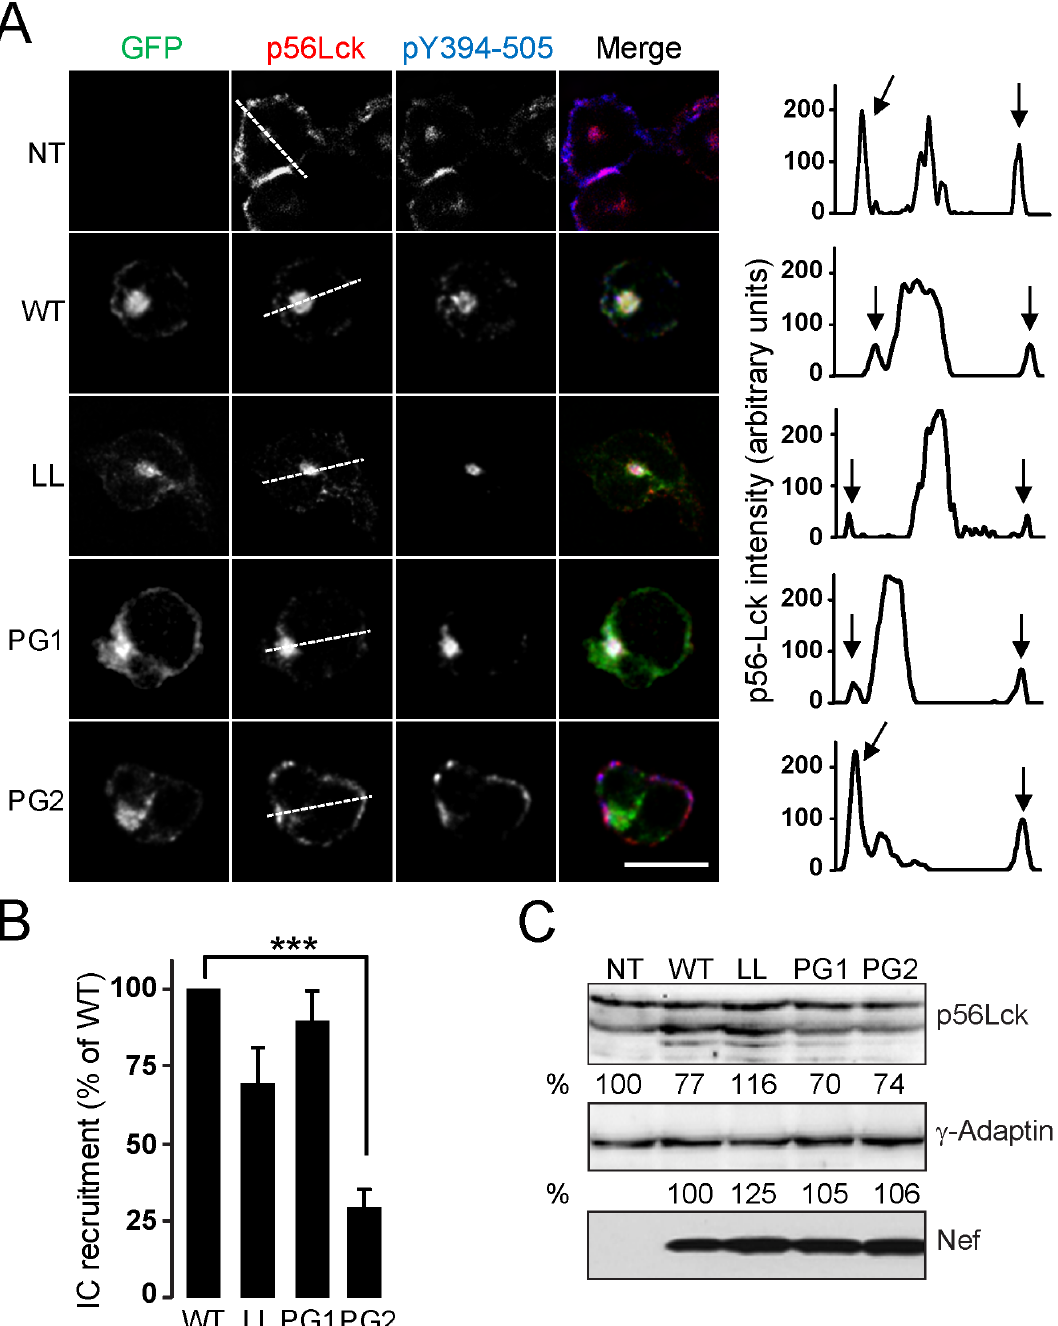
Fig 5. The GPG-motif is required for Nef-induced intracellular recruitment of p56 Lck . (A-B) The subcellular distribution of endogenous p56 Lck and pTyr- Lck was analysed by indirect immunofluorescent staining of non-transfected, NT, or transfected Jurkat cells with the expression plasmids for wild type or the indicated Nef-GPG mutants as GFP-fusion proteins. A) A medial optical section of a representative cell is shown. Densitometry analysis of the distribution of endogenous p56 Lck staining along the line in Jurkat cells expressing the indicated Nef-GFP proteins. Arrows indicate the position of the cell periphery (right panels). Scale bar, 10 μ m. B) Quantification of the experiment shown in A. The percentage of cells with high levels of intracellular p56 Lck was measured as described in Materials and Methods. Histograms represent the cells with predominant intracellular localization of p56 Lck compared to control cells, respectively. Values are the arithmetic mean ± SD of at least three independent experiments in which over 100 cells were counted per condition. *** , p < 0.001. C) The expression of endogenous p56 Lck and transfected Nef-GFP proteins in Jurkat cells was analysed by western blotting using an anti-p56 Lck antibody and an anti-GFP antibody, respectively. γ -adaptin was used as loading